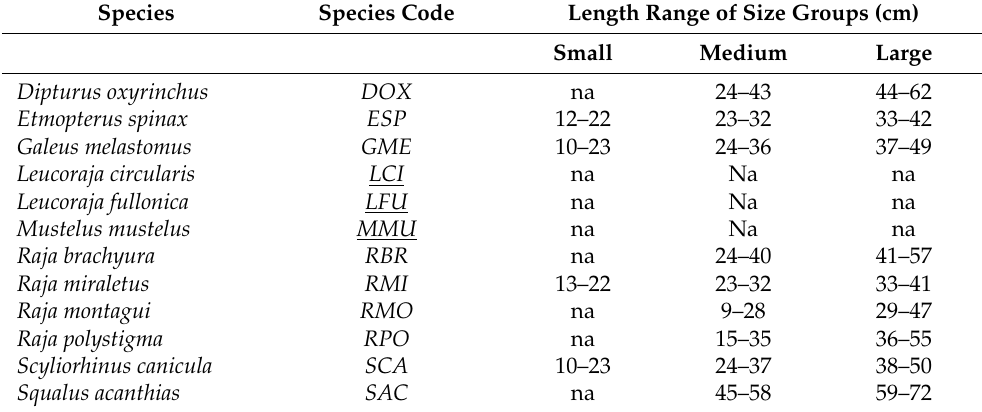
Table 2. Species code (letters denote the initial letter and the first two letters of the genus and species name, respectively) arranged in alphabetical order and the length range of the size groups (small, medium, and large) used in the analysis of the vitality rates variation with size in twelve species of elasmobranchs after capture through a fishery-independent trawl survey in the Asinara Gulf during June–October 2022. The underlined species were excluded from quantitative analyses. Species codes are based on the initial letter and the first two letters of the genus and the species name, respectively. Species Species Code Length Range of Size Groups